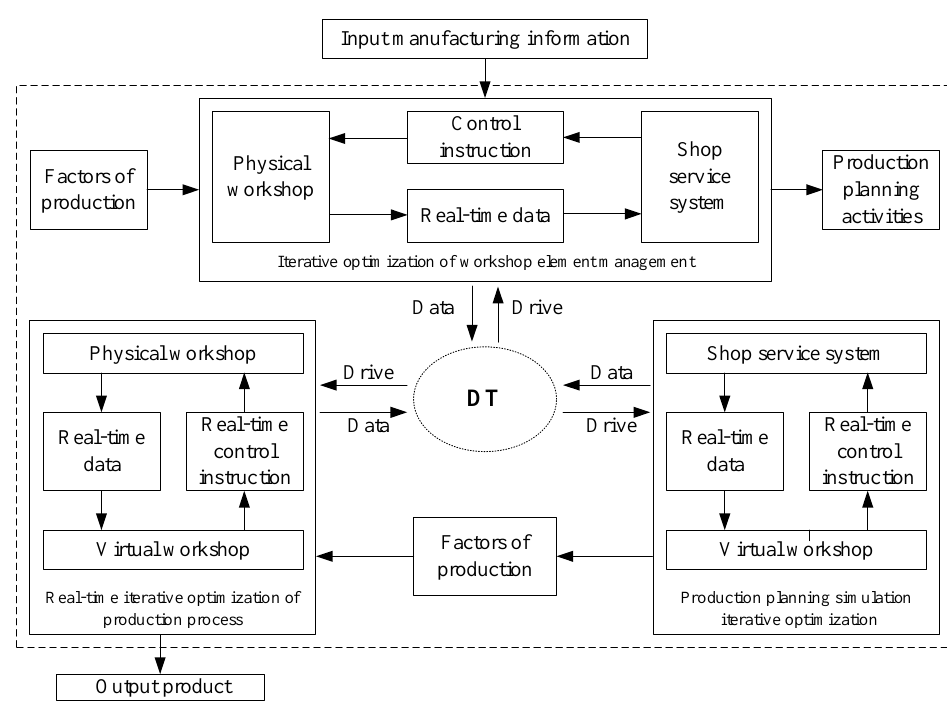
Figure 2. The operational mechanism of DT shop-floor [48].